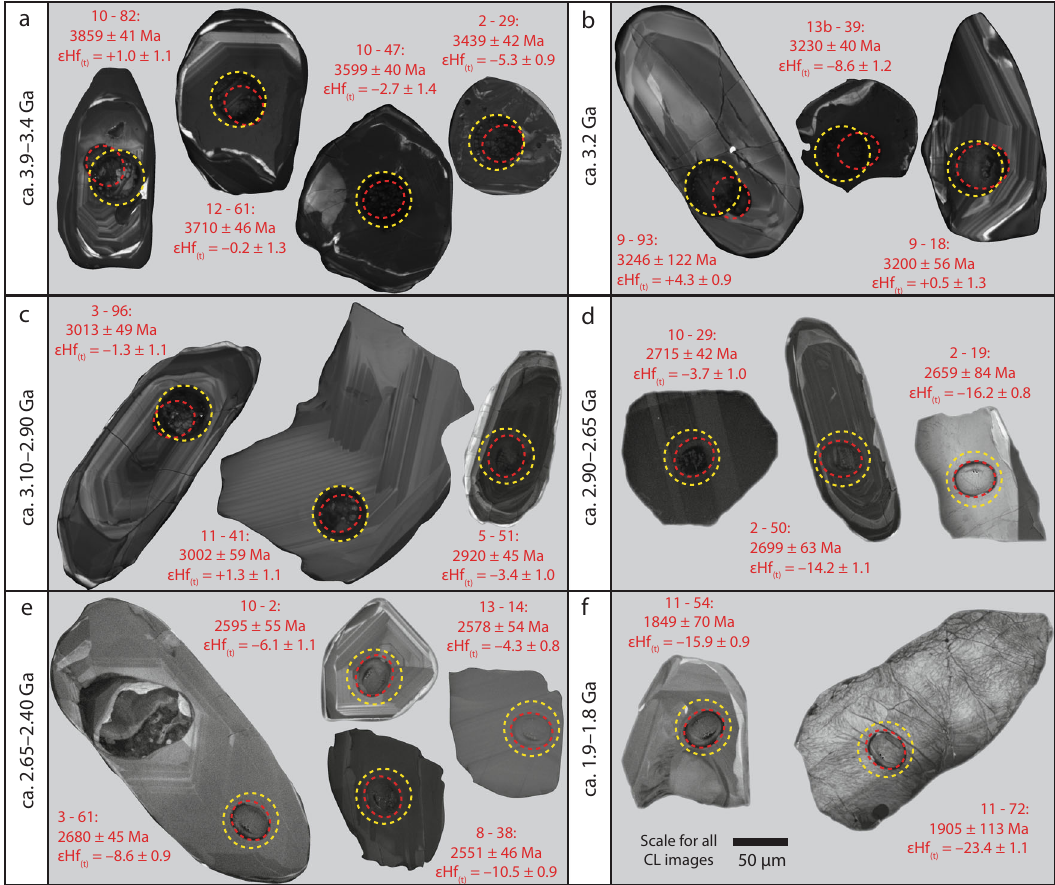
Fig. 2 Cathodoluminescence images of detrital zircon grains. Representative cathodoluminescence images of detrital zircon grains from stream sediments of the northern North Atlantic Craton. Panels show zircon of a ca. 3.90 – 3.40 Ga, b ca. 3.20 Ga, c ca. 3.10 – 2.90 Ga, d ca. 2.90 – 2.65 Ga, e ca. 2.65 – 2.40 Ga, and f ca. 1.90 – 1.80 Ga age. Red and yellow circles denote U-Pb and Lu-Hf analytical sites, respectively. Images of all grains are provided in Supplementary Data